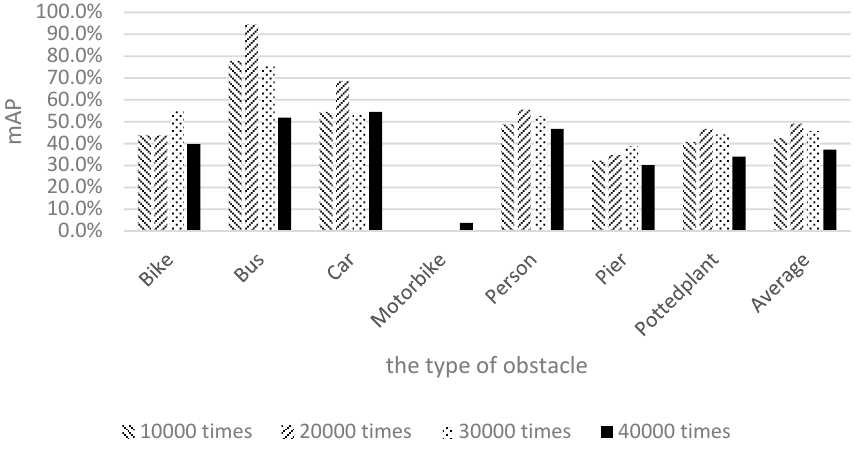
Figure 16. Results of using only 1710 images captured by the researchers of this study.